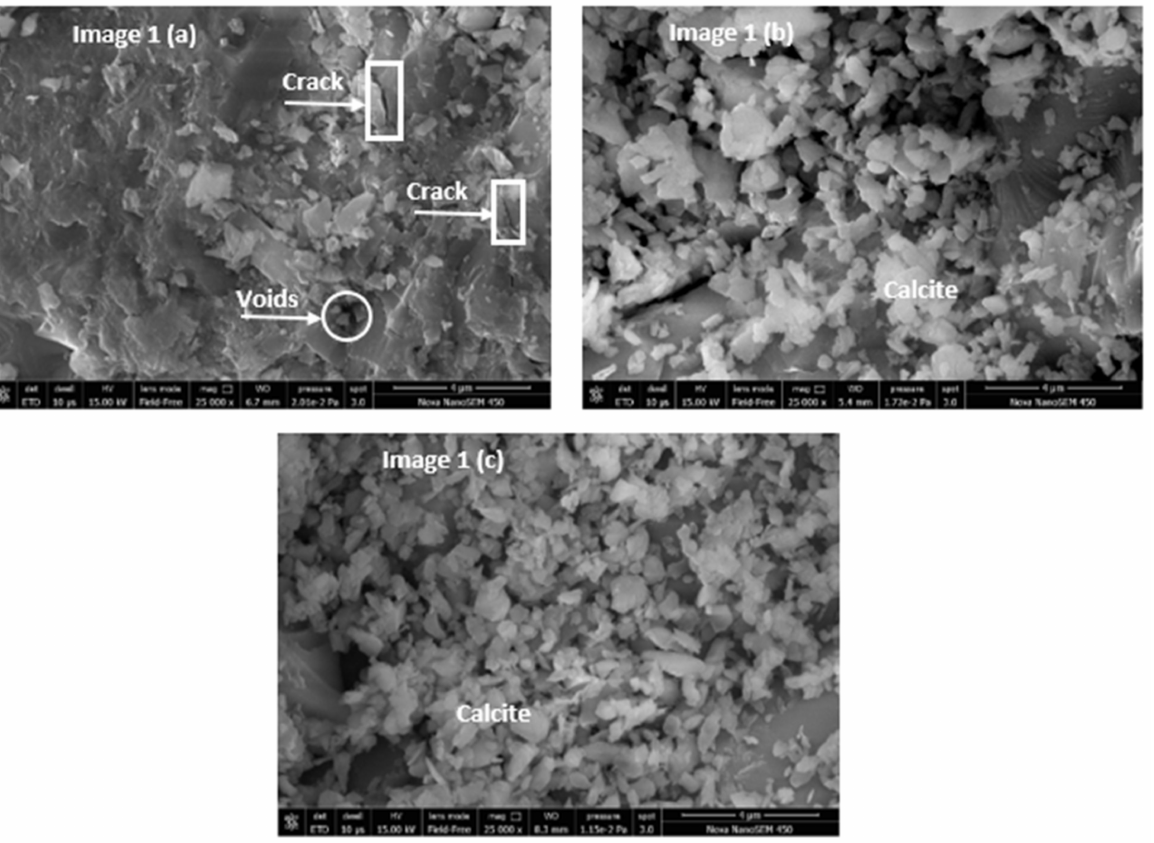
Figure 9. SEM image of conventional concrete and bacterial concrete for 28 days. Image 1 ( a ) conventional concrete sample after 28 days, Image 1 ( b ) 10 6 cf/mL Pseudomonas Bacterial concrete after 28 days, and Image 1 ( c ) 10 7 cf/mL Pseudomonas Bacterial concrete after 28